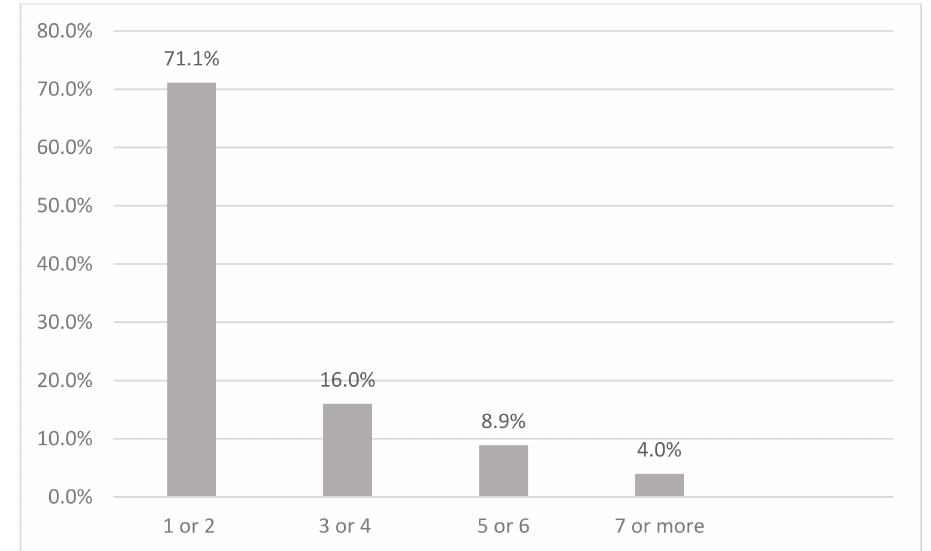
Figure 3. Number of drinks consumed on a typical day among current drinkers in Malaysia.